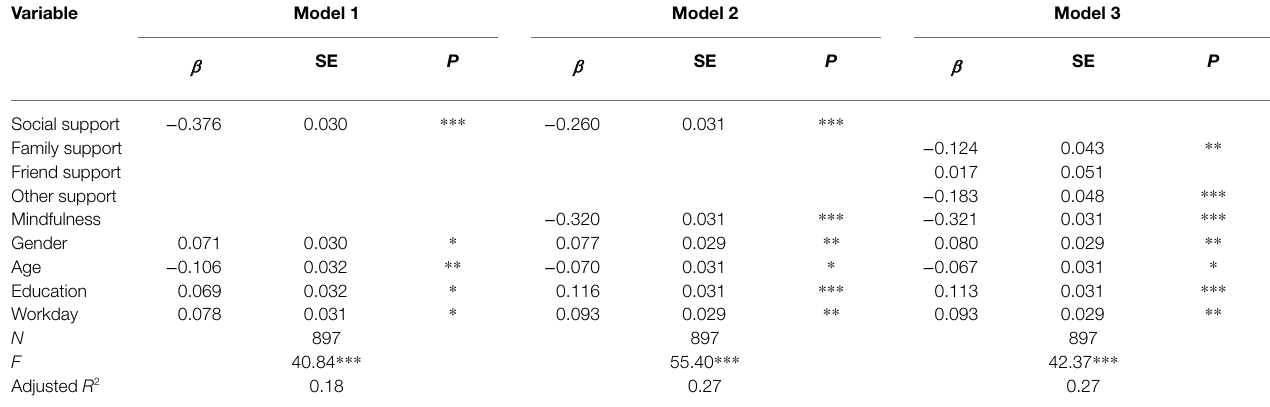
TABLE 2 | Regression analysis of job